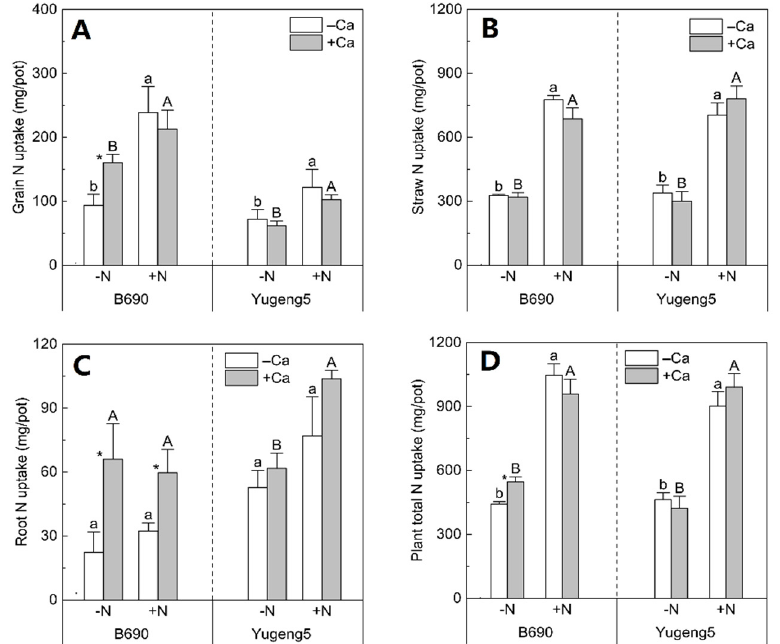
Figure 4. E ff ects of nitrogen (N) and lime on N uptake of rice cultivars ‘B690’ and ‘Yugeng5’. ( A ), Grain N uptake; ( B ), straw N uptake; ( C ), root N uptake; ( D ), plant total N uptake. Two rice cultivars were grown in pots in a greenhouse without ( − N) or with ( + N) N fertilizer, in the absence ( − Ca) or presence ( + Ca) of lime, till maturity. Di ff erent lowercase and capital letters above bars indicate significant di ff erences between − N and + N treatments under − Ca and + Ca conditions for the same rice cultivar, respectively ( p < 0.05, independent-sample t test). Asterisks indicate significant di ff erences between − Ca and + Ca treatments for the same rice cultivar ( p < 0.05, independent-samples t test).